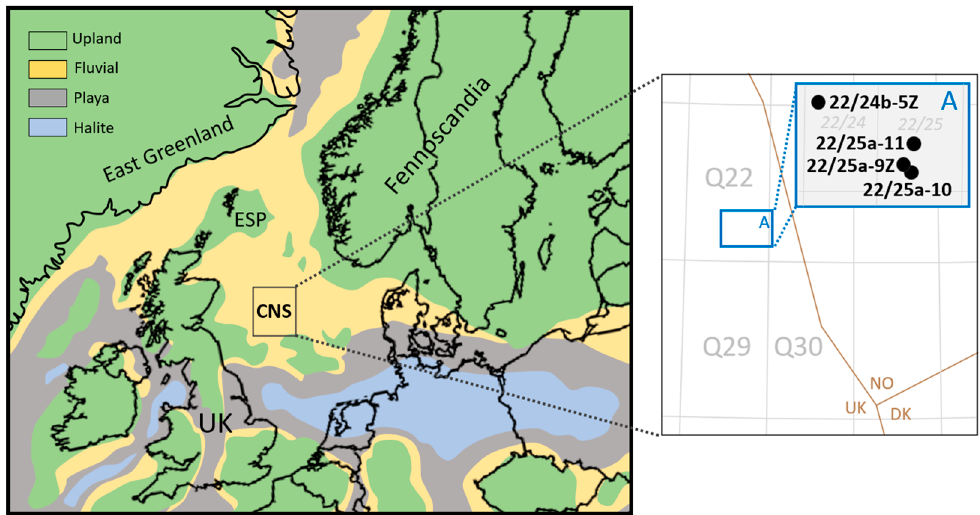
Figure 1. Middle Triassic (Judy Sandstone Member) palaeogeographic reconstruction of NW Europe showing location of the study area and wells discussed in this paper, modified from McKie [5].